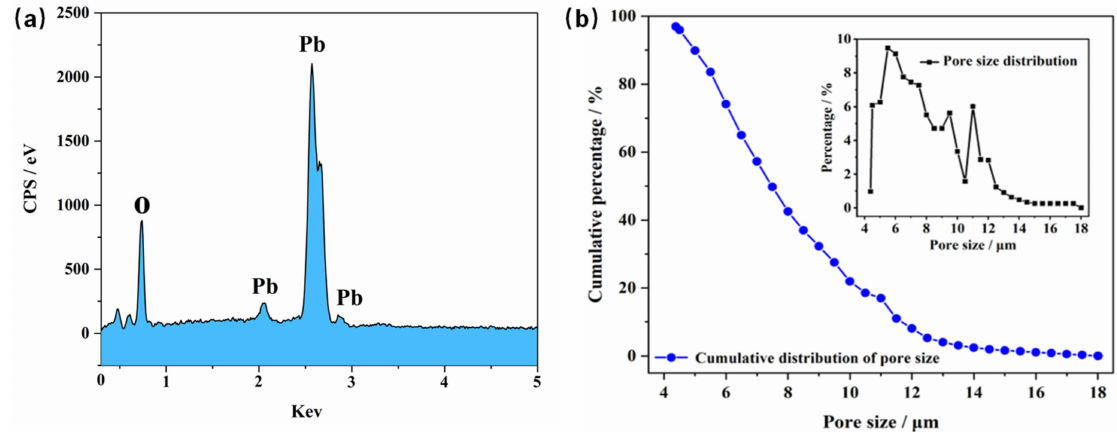
Figure 3. ( a ) EDS spectrum of PbO 2 -REM; ( b ) pore size distribution of PbO 2